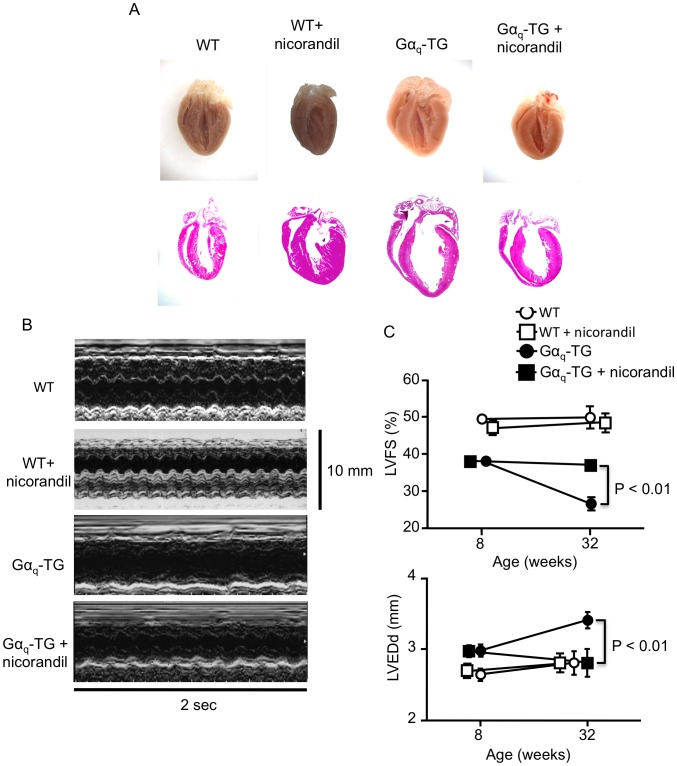
Effects of nicorandil on cardiac morphology and on the left ventricular contractile function.Panel A: Gross examination of the four-chamber section of a heart and its histology stained with hematoxylin/eosin in a WT (wild-type), WT+nicorandil, Gαq-TG, and GαqTG+nicorandil mouse heart. Original magnification: 1.25×. Panel B: Representative M-mode echocardiograms of a WT, WT+nicorandil, Gαq-TG, and GαqTG+nicorandil mouse at the age of 32 weeks. Panel C: Age-dependent changes in left ventricular fractional shortening (LVFS) and left ventricular end-diastolic dimension (LVEDd) in WT, WT+nicorandil, Gαq-TG, and GαqTG+nicorandil mice. WT+nicorandil, nicorandil-treated WT; Gαq-TG, vehicle-treated Gαq-TG; GαqTG+nicorandil, nicorandil-treated GαqTG. Mice at age of the 32 weeks were used.